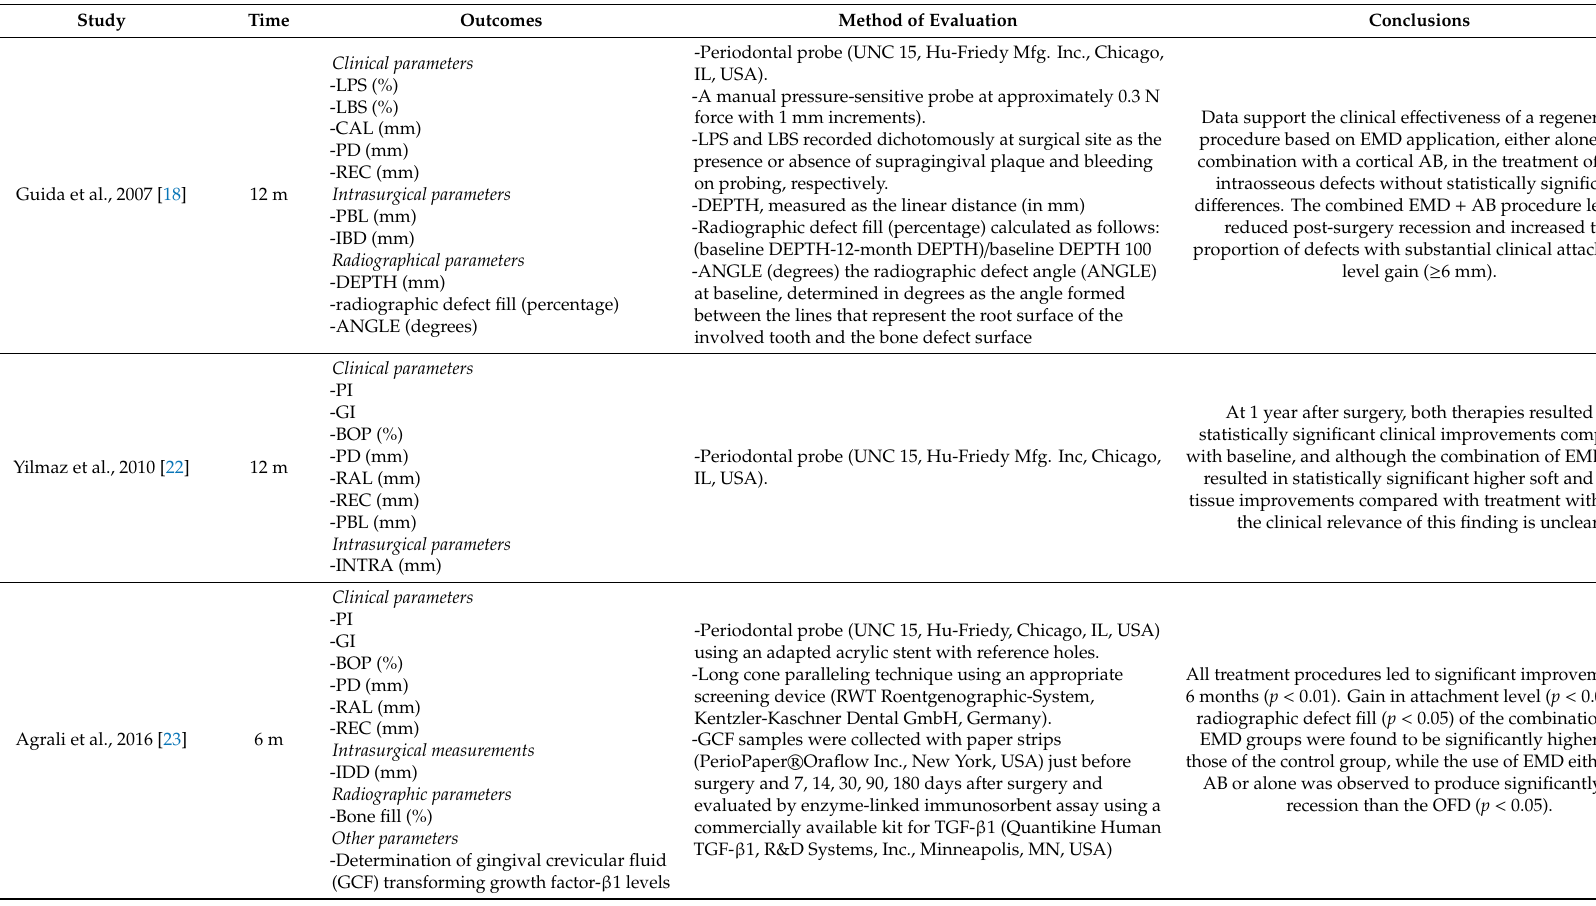
Table 3. Main characteristics of selected studies: outcomes, methods of evaluation, and